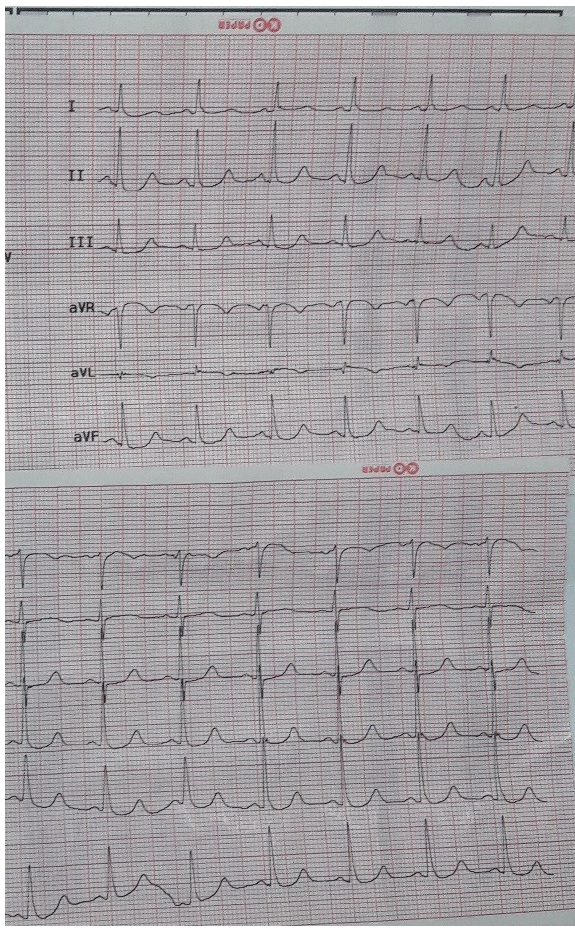
Figure 1. Second ECG After Fainting With ST Depression in Lead II, III and aVF. Note . ECG: Electrocardiography.